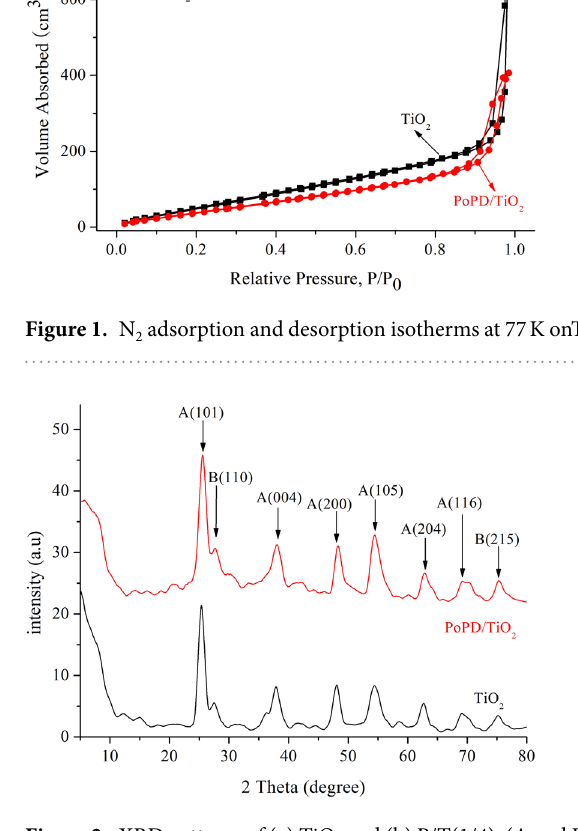
Figure 2. XRD patterns of (a) TiO 2 and (b) P/T(1/4). (A and B represent anatase and rutile TiO 2 ,